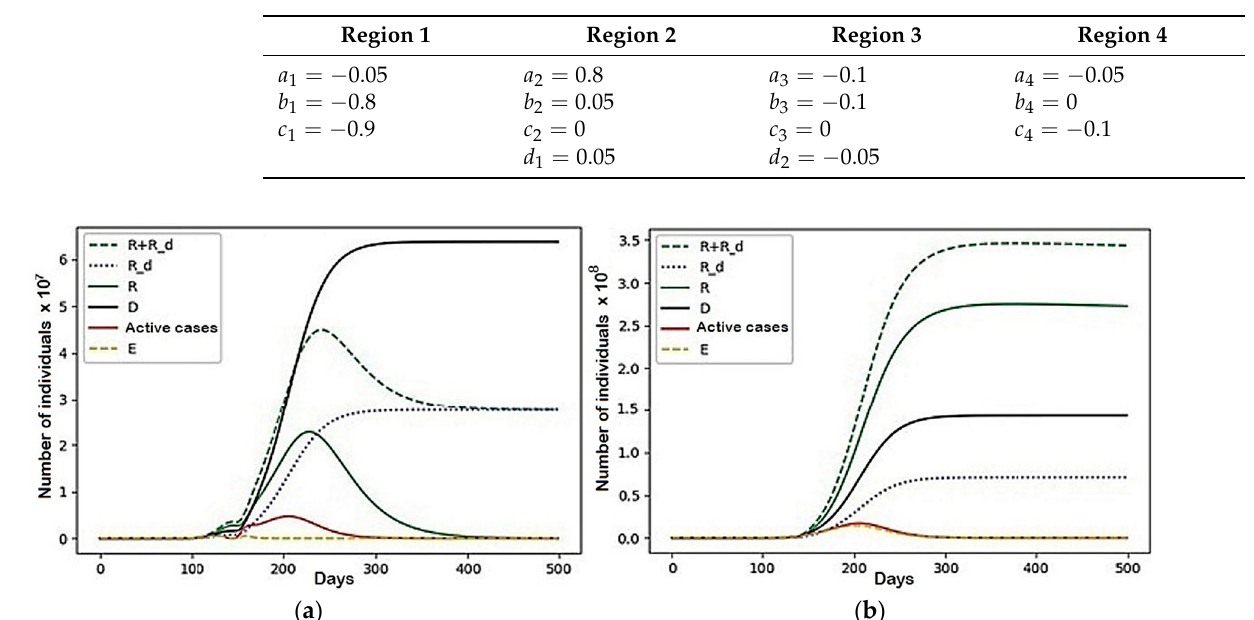
Figure 13. A scenario with the parameters represented in Table 2: ( a ) Region 3; ( b ) Region 4.